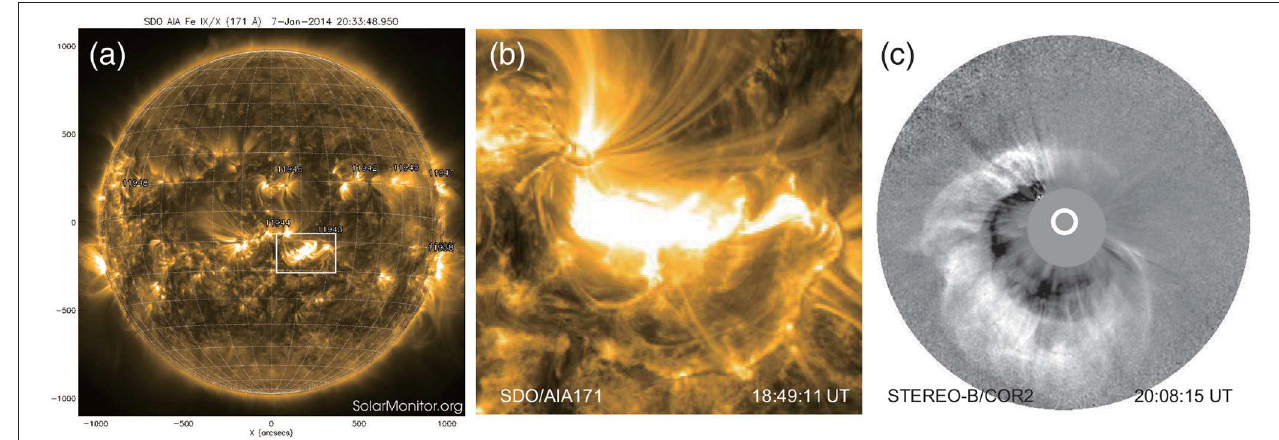
FIGURE 1 | (a) Location of the flare site in a full-disk SDO /AIA 171 Å image. The number of the ARs are labeled, and the boxed region denotes the flare site. (b) Enlarged view of the flaring loops during the X1.2 flare. (c) A running difference image of the CME from the flare region observed by